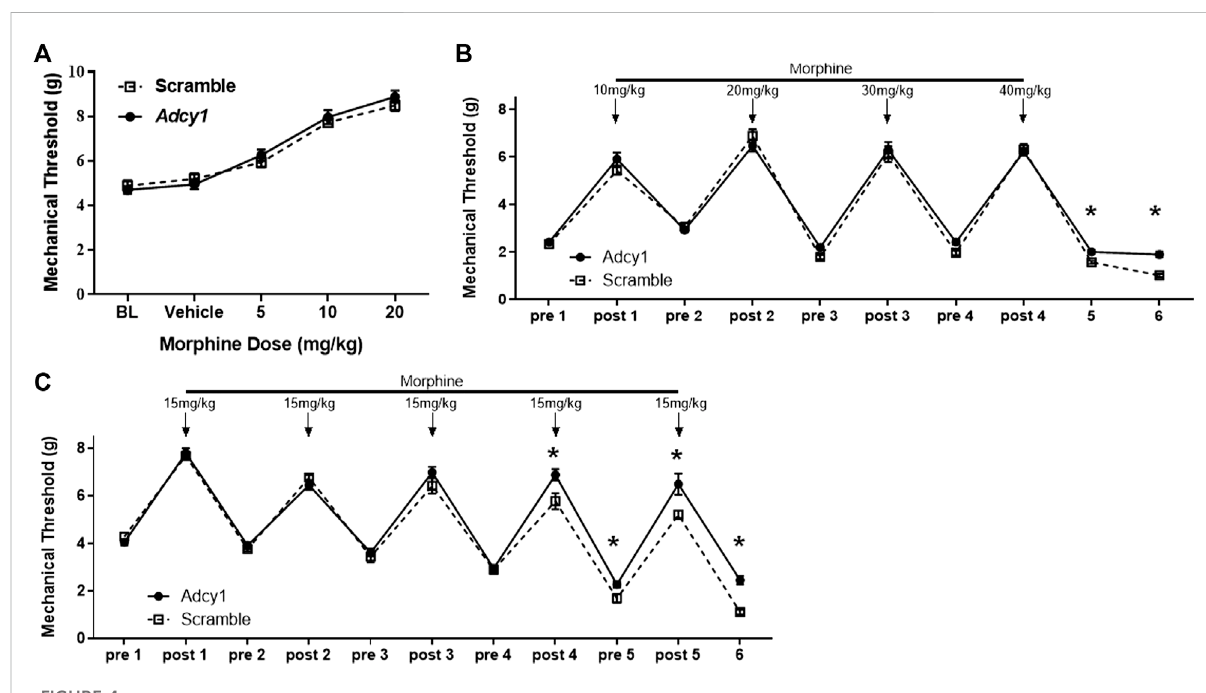
FIGURE 4 AC1 knockdown via intrathecal delivery of AAV9-Adcy1-shRNA partially attenuates morphine induced hyperalgesia in mice. (A) Knockdown of Adcy1 mRNA does not impact acute morphine antinociception (5 – 20 mg/kg, sc, measurements taken 30 min after morphine injection). (B) Twice daily escalating injections of morphine (10 mg/kg on day 1 increasing to 40 mg/kg by day 4, sc, 100 µl) induce hyperalgesia that is attenuated in AAV9-Adcy1-shRNA compared to AAV9-Scrambl-shRNA injected mice on Days 5 and 6, ~18 and ~42 h after last morphine injection, respectively (repeated measures ANOVA, F (1, 18) = 3.928, p = 0.00630). (C) Morphine tolerance and hyperalgesia established by twice daily injections of morphine for 5 days (15 mg/kg, sc) are reduced in AAV9-Adcy1-shRNA compared to AAV9-Scrambl-shRNA injected mice (F (1, 18) = 17.61, p = 0.0005). Asterisk indicates statistical signi fi cance at each individual time point ( p < 0.05). Data presented as mean ± SEM with an n = 10/